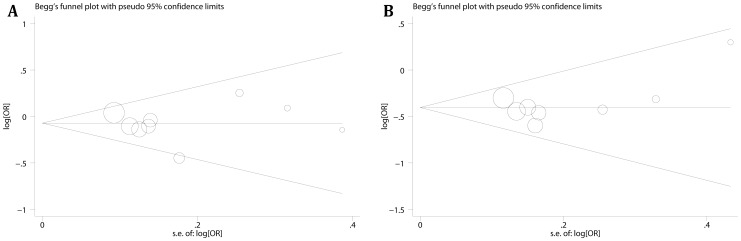
Funnel plots for −667T>C and −842G>C polymorphism.A: heterozygote comparison (TC vs. TT) of −667T>C polymorphism estimated with adjusted ORs and 95% CIs, PBegg = 0.917, PEgger = 0.89; B: dominant model (GC+CC vs. GG) of −842G>C polymorphism calculated with adjusted ORs, PBegg = 0.536, PEgger = 0.366.